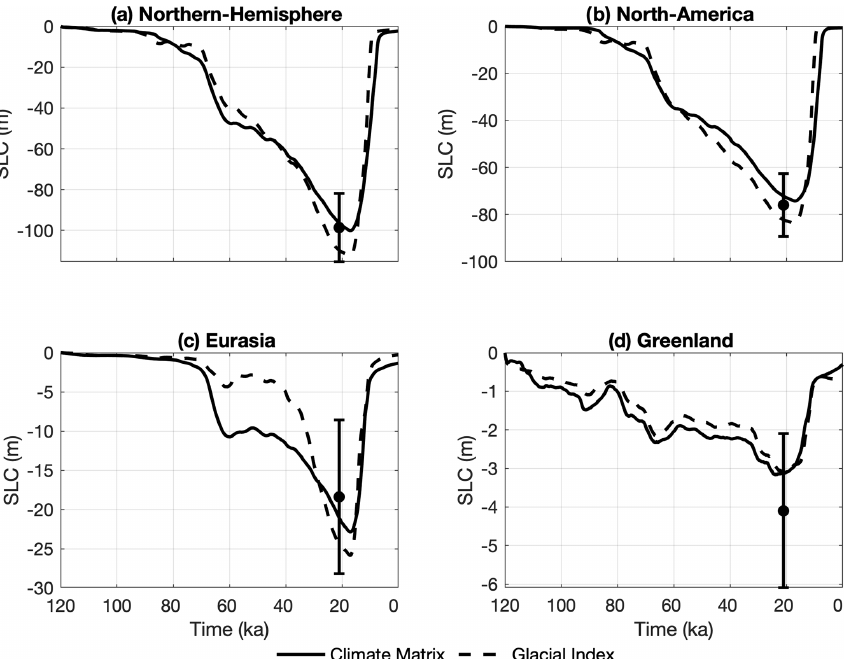
Figure 9. Sea level contribution during the LGC for simulations forced by PMIP3-Ensemble using either the glacial index or climate matrix method. The error bars indicate the sea level contribution by Simms et al.